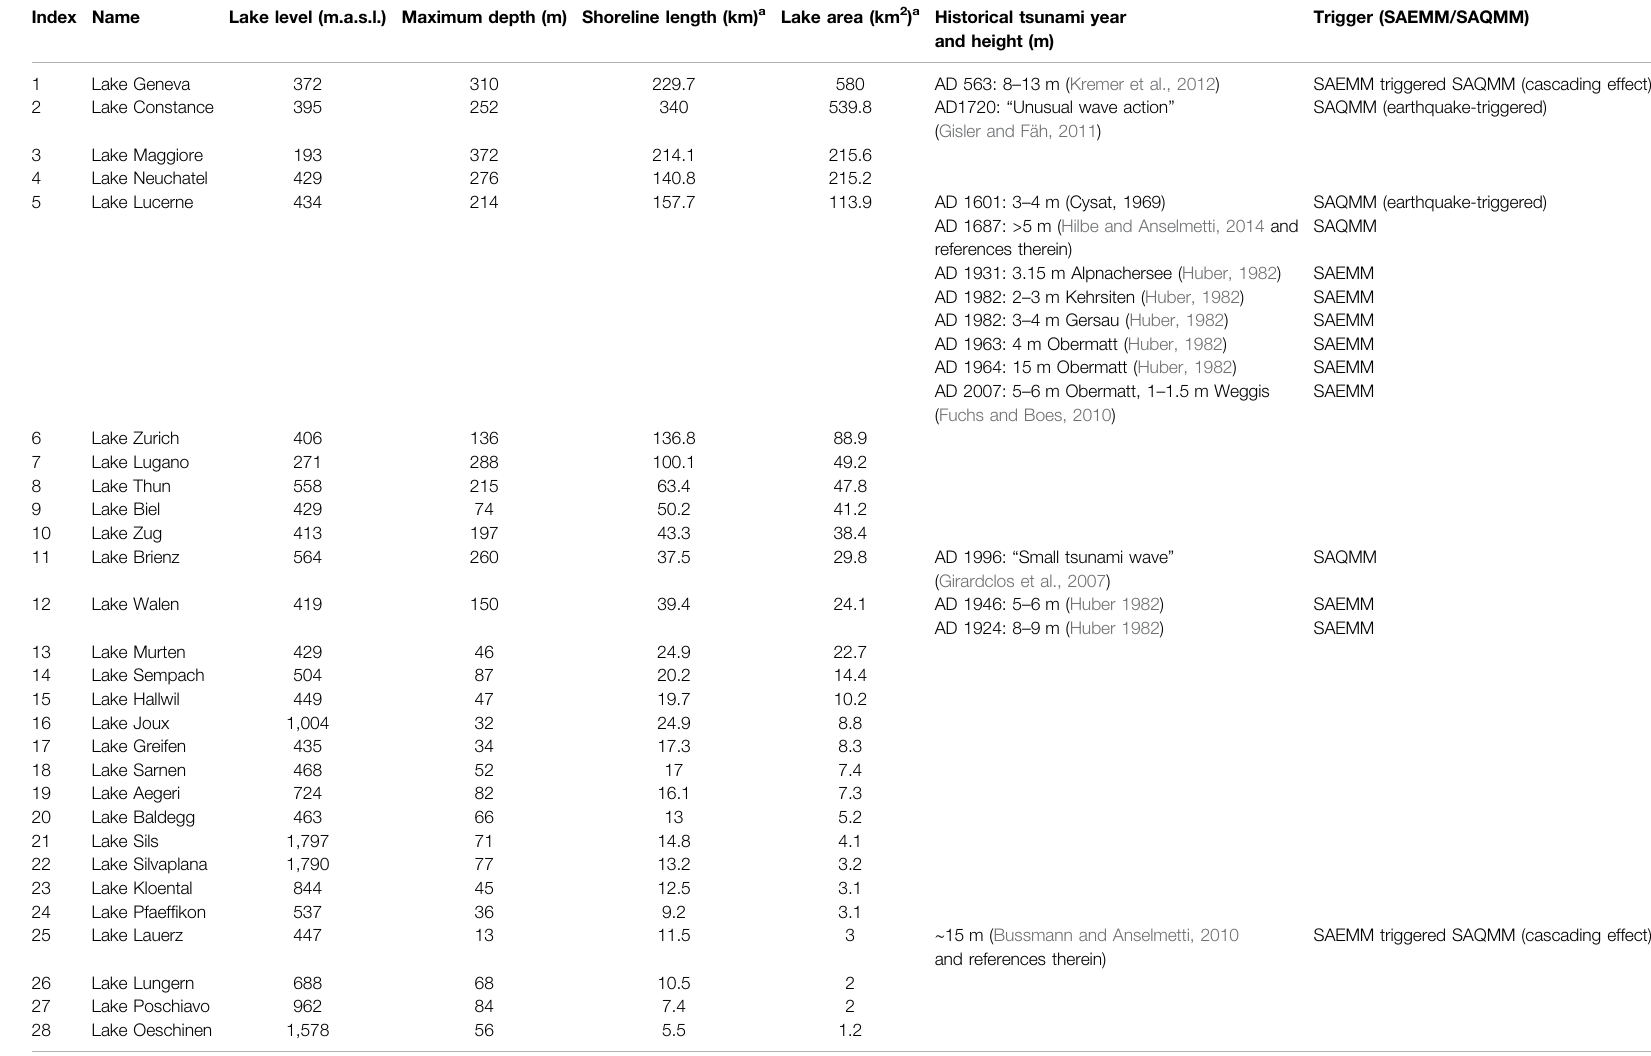
TABLE 1 | Characteristics of the Swiss lakes with surface areas > 1 km (reservoirs excluded), sorted by lake area. Information extracted from swisstopo data. Index